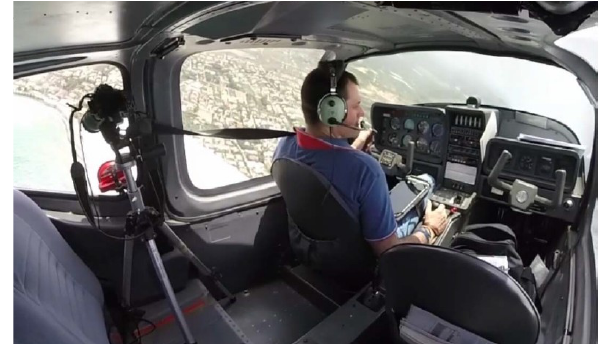
Figure 9. Oblique photos